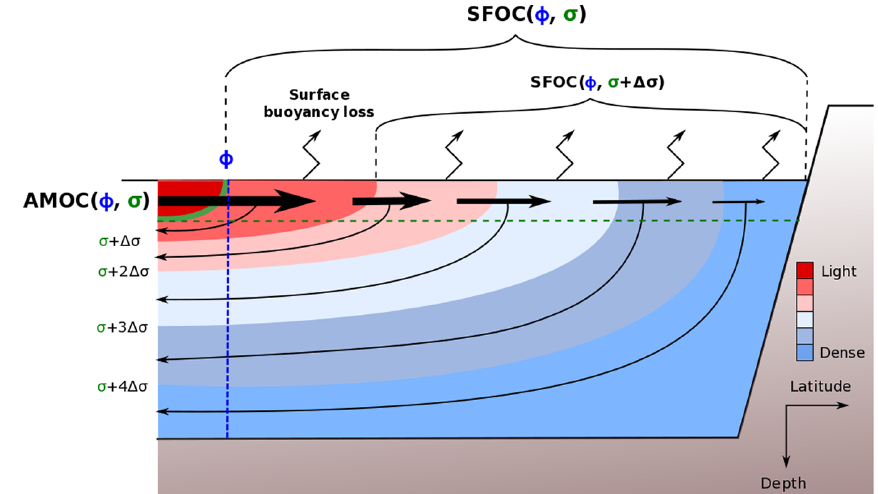
Figure 1. Schematic of the relationship between meridional overturning circulation at latitude φ and isopycnal surface σ – the AMOC ( φ , σ ) – and its surface-forced component – the SFOC ( φ , σ ). Arrows show the progressive transformation of waters across increasing density surfaces balanced by buoyancy loss at the air–sea interface and meridional import and export. Inspired from Marsh